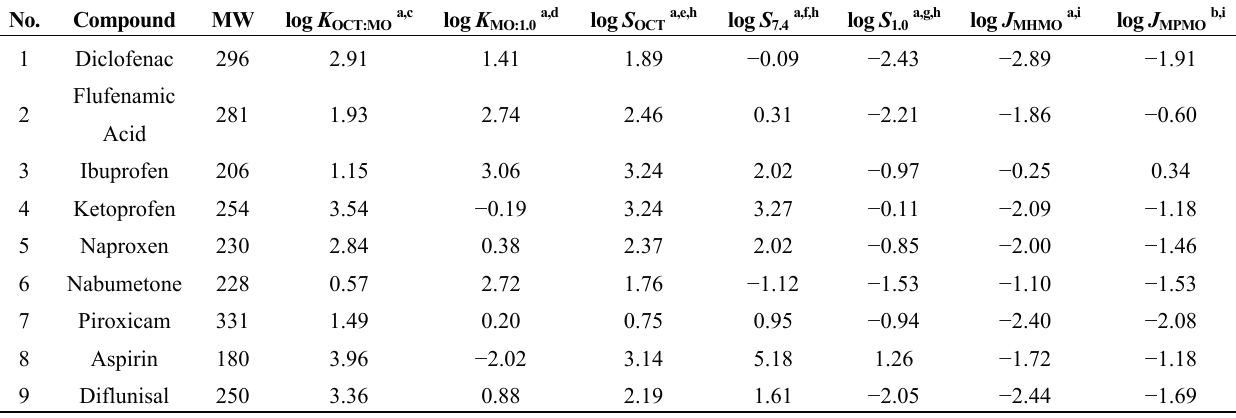
Table 1. Molecular weights; calculated log partition coefficients; calculated solubilities; flux through human skin in vivo ; flux through silicone